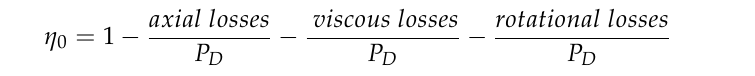
Table 1. Propulsive factors. η 0 η R η H Axial losses Wake adaption (represents the swirl Rotational losses kinetic energy added to the wake Viscous losses behind the propeller.) Non-uniformity (e.g., blades, etc.)